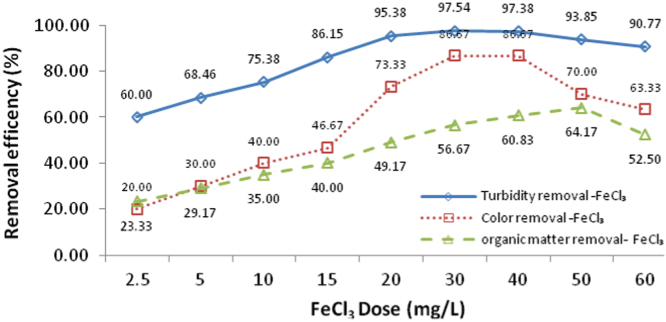
Affect of FeCl3 at various doses (from 2.5 to 60 mg/L) on turbidity, color and organic matter removal from SFBW.